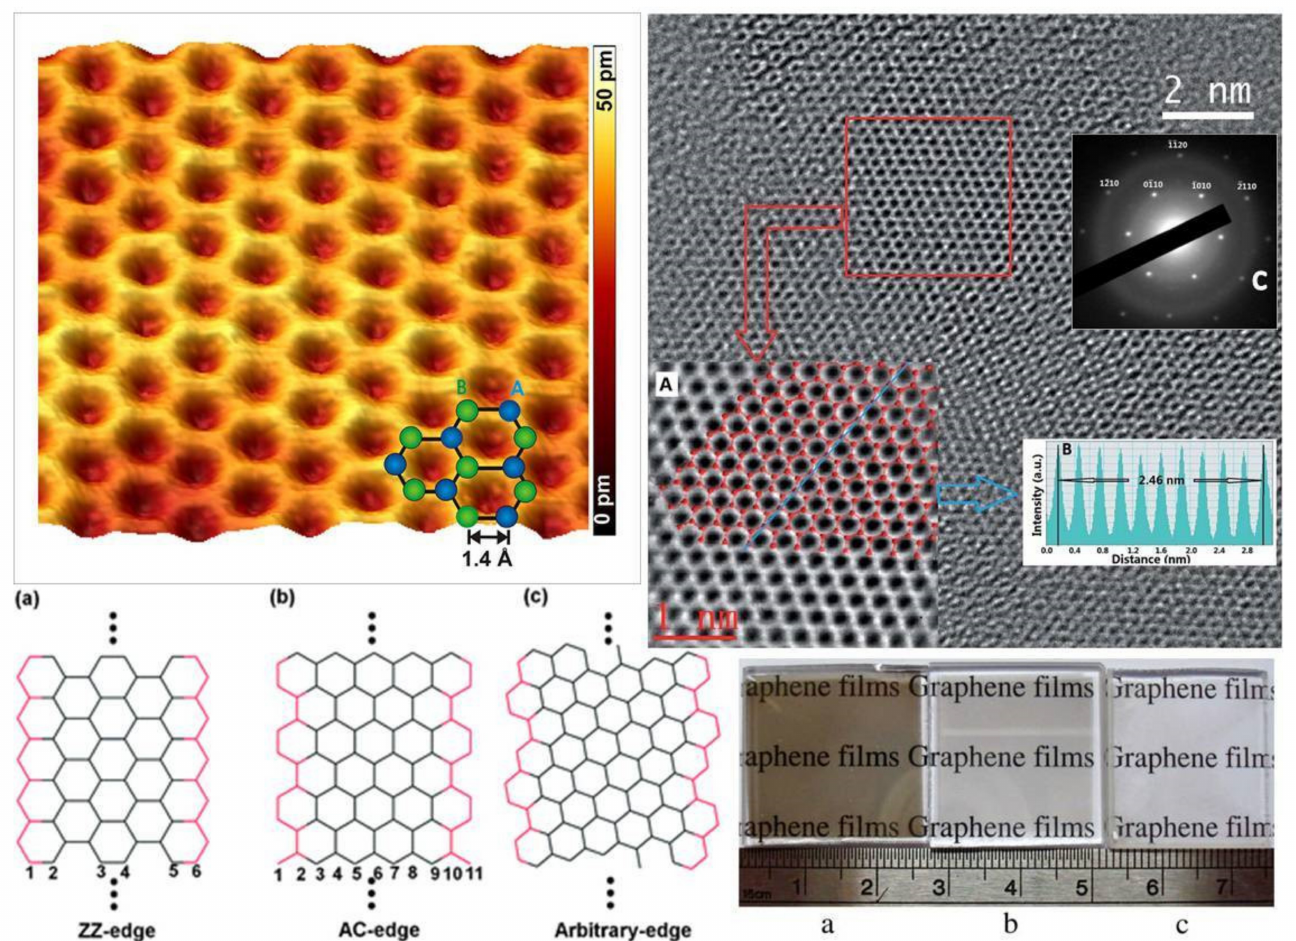
Figure 1. ( Top left ) STM topography reveals atomically resolved graphene lattice. The blue and green spheres indicate two carbon atoms of the unit cell, labelled A and B. (Reproduced with permission from ref [19]). ( Top right ) High-resolution images of graphene (the scale bar is 2 nm). Inset ( A ): the filtered image of the area within the red rectangular frame. Inset ( B ): pixel intensity profile of the graphene along the blue line in inset ( A ), which was used to calculate the distance between the second-nearest neighboring carbon atoms in the hexagonal carbon ring. Inset ( C ) Normal-incidence selected area electron diffraction pattern of graphene. (Reproduced with permission from ref [20]. ( Bottom right ) Graphene films with different thicknesses ( a ) 86 nm, ( b ) 22 nm, and ( c ) 14 nm. (Reproduced with permission from ref [21]. ( Bottom left ) Various graphene nanoribbons (GNRs): ( a ) zigzag GNR (ZGNR), ( b ) armchair GNR (AGNR), and ( c ) chiral GNR (CGNR). The numbers 1, 2, 3, . . . in ( a , b ) indicate the zigzag and armchair chains of the GNRs and their width. (Reproduced with permission from ref